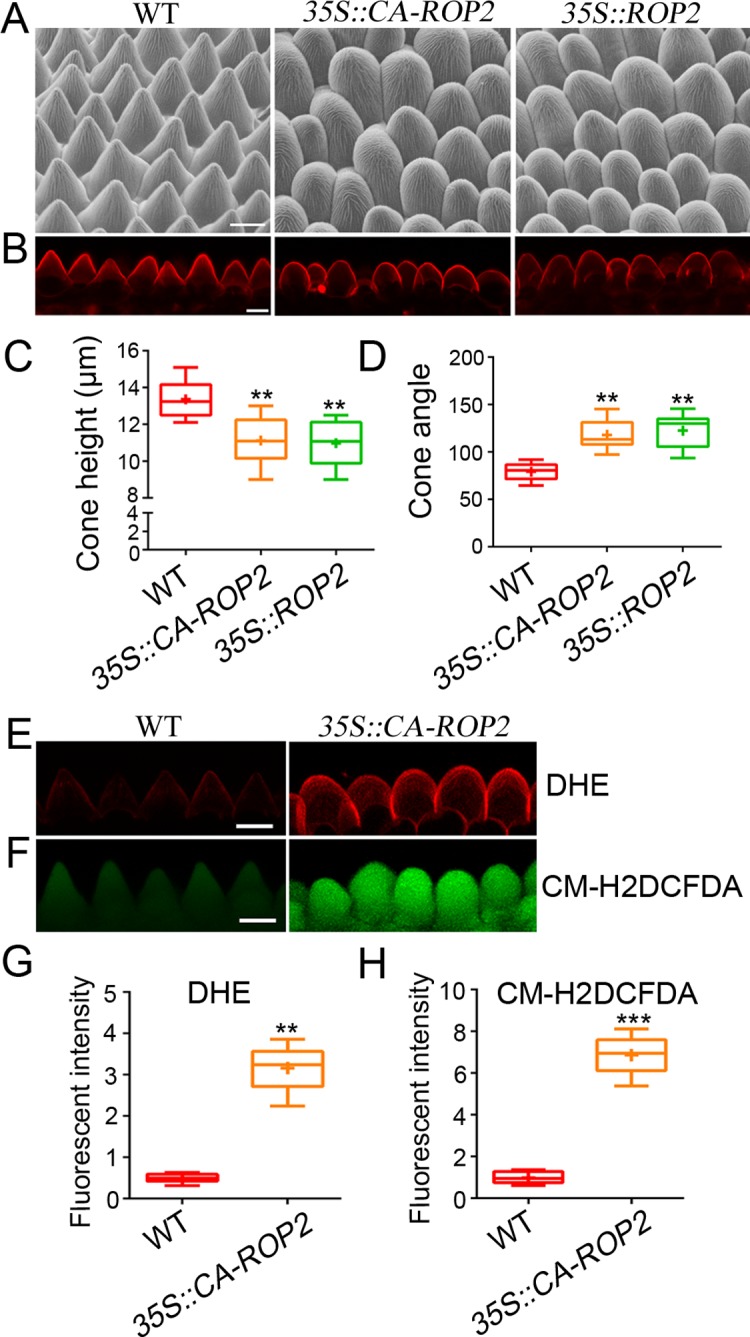
ROP2 overexpression leading to high levels of ROS and swollen conical cells.(A and B) ROP2 overexpression leads to a reduced tip sharpening phenotype in conical cells. Scanning electron microscope (A) and confocal (B) images of conical cells of WT, 35S::CA-ROP2, and 35S::ROP2 from stage 14 flowers. Scale bars represent 10 μm. (C and D) Quantification of conical cell phenotypes from WT, 35S::CA-ROP2, and 35S::ROP2. For the quantification of cone height, asterisks indicate a significant difference (Mann–Whitney U test, **P < 0.01) (P = 0.0095, P = 0.0051, respectively). For the quantification of cone angle, asterisks indicate a significant difference (Mann–Whitney U test, **P < 0.01) (P = 0.00261, P = 0.00123, respectively). Values are given as the mean ± SD of more than 300 cells from 20 petals from three independent plants. (E and F) DHE- and CM-H2DCFDA-stained conical cells of WT and 35S::CA-ROP2 from stage 14 flowers. Scale bars represent 10 μm. (G and H) Quantification of DHE-detected O2• – (G) and CM-H2DCFDA-detected H2O2 (H) in conical cells. For comparative O2• – and H2O2 analysis, a region of interest (ROI) in the conical cells was quantified by ImageJ. For the quantification of DHE-detected O2• –, asterisks indicate a significant difference (Mann–Whitney U test, **P < 0.01) (P = 0.0033). For the quantification of CM-H2DCFDA-detected H2O2, asterisks indicate a significant difference (Mann–Whitney U test, ***P < 0.001) (P = 0.0005). Values are given as the mean ± SD of more than 100 cells from 10 petals.